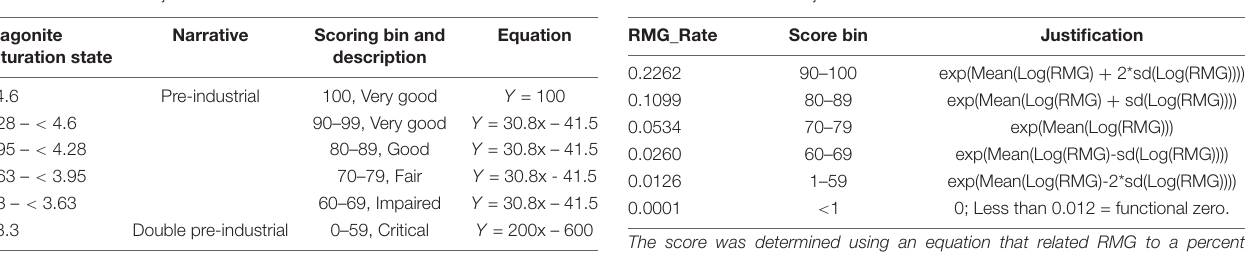
TABLE 4 | Ocean acidification assessment points and associated scoring for all United States coral reef